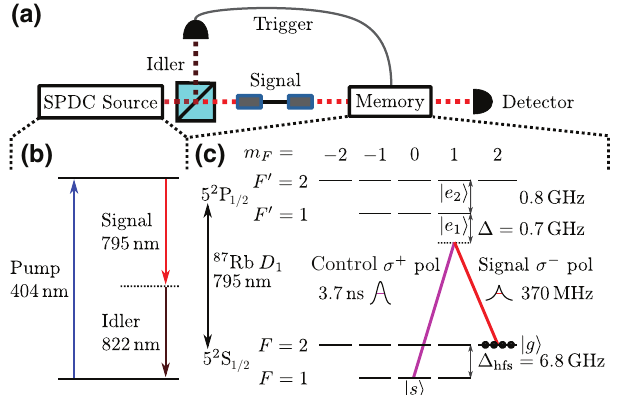
FIG. 1. (a) Basic scheme of the experiment. (b) Energy lev- els of the photon source. By spontaneous parametric down- conversion in PPKTP, 404 nm pump photons are converted to 795 nm signal and 822 nm idler photons. (c) Energy level scheme for the atomic memory. Optical pumping and selection rules are used to isolate a four-level lambda system on the 87 Rb D 1 line. The σ − polarized signal is detuned by (cid:3) from the F = 2 → F (cid:3) = 1 transition and the σ + polarized control is equally detuned from F = 1 → F (cid:3) = 1. Photons can thus be stored as a spin wave excitation between the initially prepared ground state | g (cid:2) and the storage state | s (cid:2) via the excited states | e 1 (cid:2) and | e 2 (cid:2)